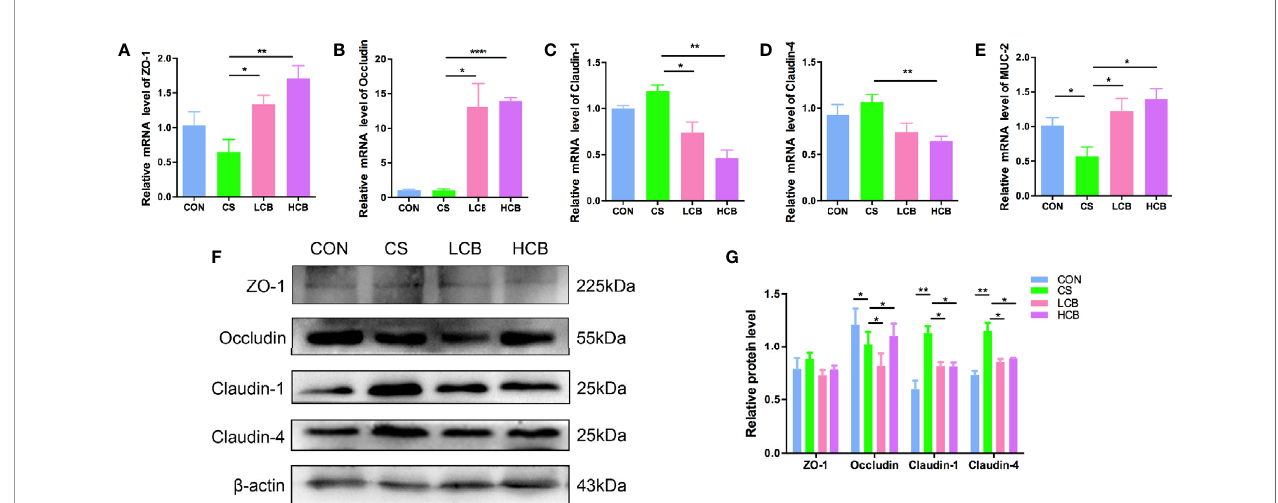
FIGURE 4 | CB RH2 enhances intestinal barrier function of ceftriaxone-treated mice. (A – E) The relative RNA expression of genes encoding zonula occludens(ZO-1), Occludin, Claudin-1, Claudin-4, andmucin-2 (MUC-2) incolon tissues of mice, detected byqPCR; (F, G) Representativeblots and comparison of protein expression of ZO-1, Occludin,Claudin-1, Claudin-4, and MUC-2 by western blot with b -actin as internalcontrol. Alldata were evaluated as mean ± SEM (n= 5), *p< 0.05, **p < 0.01, ****p <